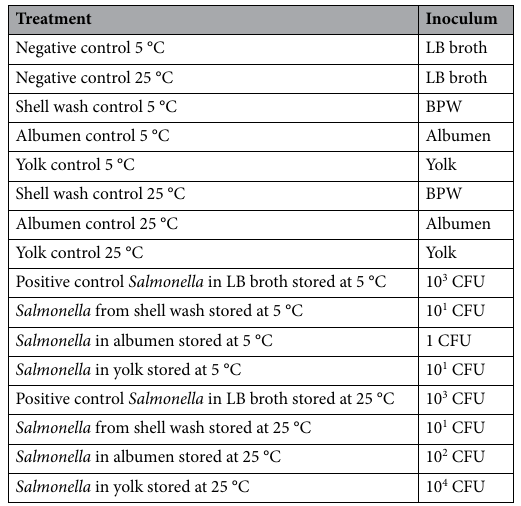
Table 1. Treatment groups and inoculum dose used in the mice